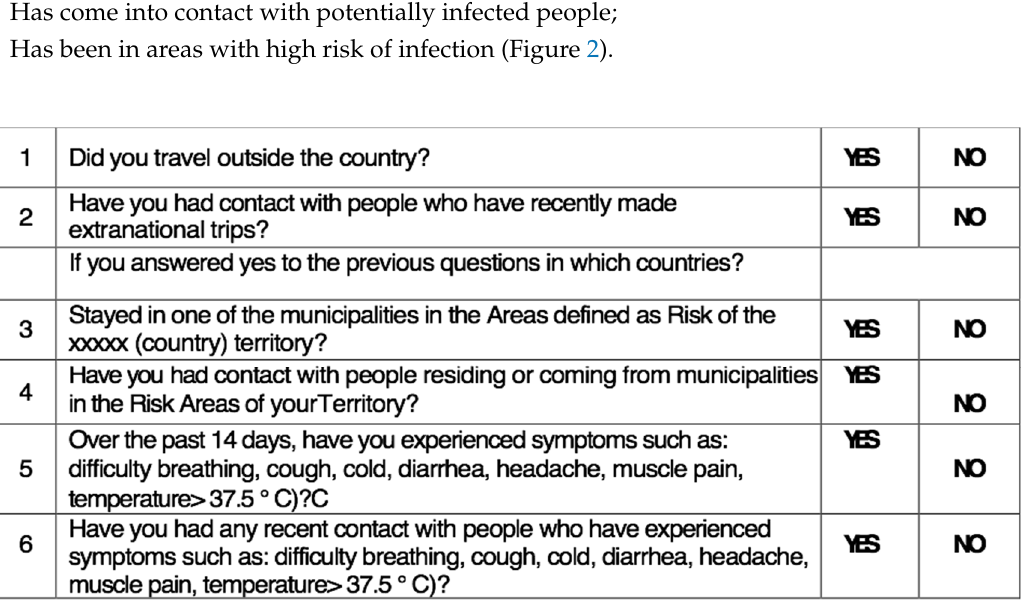
Figure 2. Additional questions to the medical record for SARS-CoV-2 (12 March 2020).